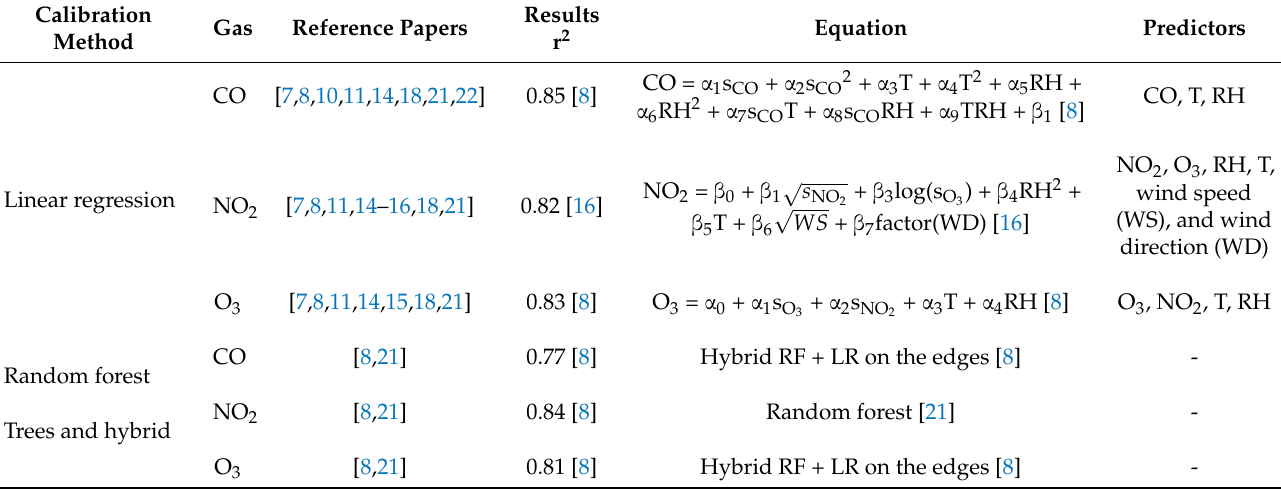
Table 1. Overview of sensor calibration